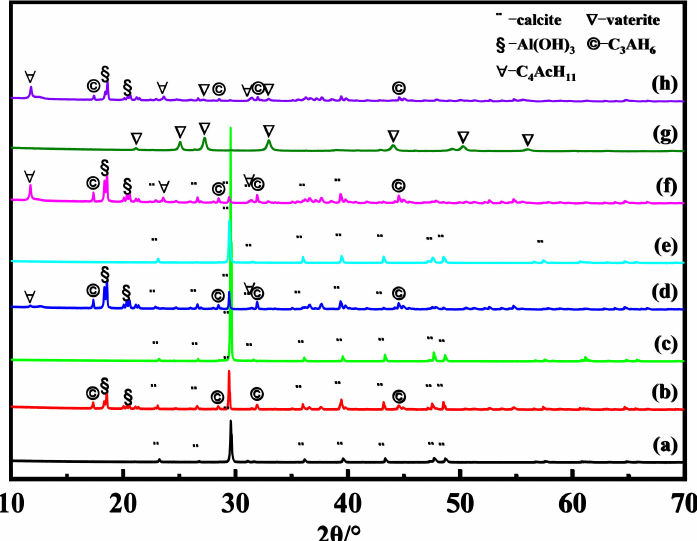
Figure 1. XRD patterns of different calcium sources and their composite samples (( a ) 400–500 mesh ground calcium carbonate, ( b ) 400–500 mesh ground calcium carbonate composite